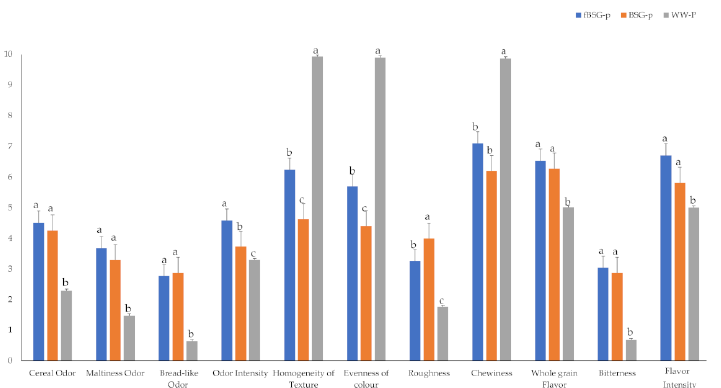
Figure 7. Sensory analysis of pasta containing fermented and native brewers’ spent grain: BSG-p, pasta containing native brewers’ spent grain; fBSG-p, pasta containing fermented brewers’ spent grain; WW-p, commercial pasta made with whole wheat (Pasta di Stigliano, Italy). The 11 sensory attributes were evaluated (on a scale 0–10, Y axis) by a sensory panel of 10 trained assessors in triplicate. Data were subjected to one-way ANOVA followed by Tukey’s procedure at p < 0.05. Bars with different letters differ significantly ( p <